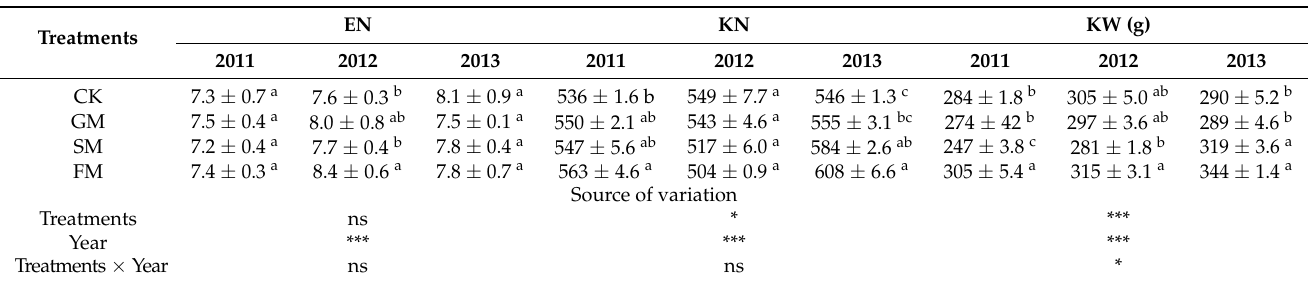
Table 3. Maize ear numbers per m 2 (EN), kernel numbers (KN) per ear, and 1000-kernel weight (KW) under the different mulching treatments in 2011, 2012, and